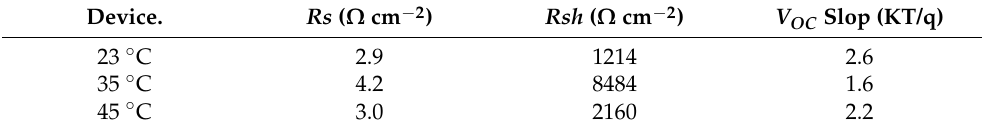
Table 2. Series resistance and shunt resistance extracted from the dark current of solar cell devices prepared at 23 ◦ C, 35 ◦ C, and 45 ◦ C, as well as the V OC slope at different light intensities.